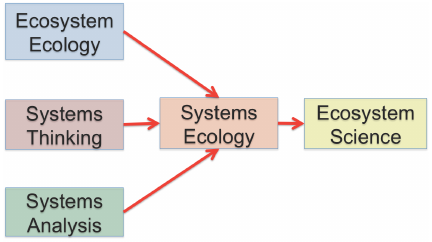
Figure 1. The relationship of ecology and systems science to ecosystem